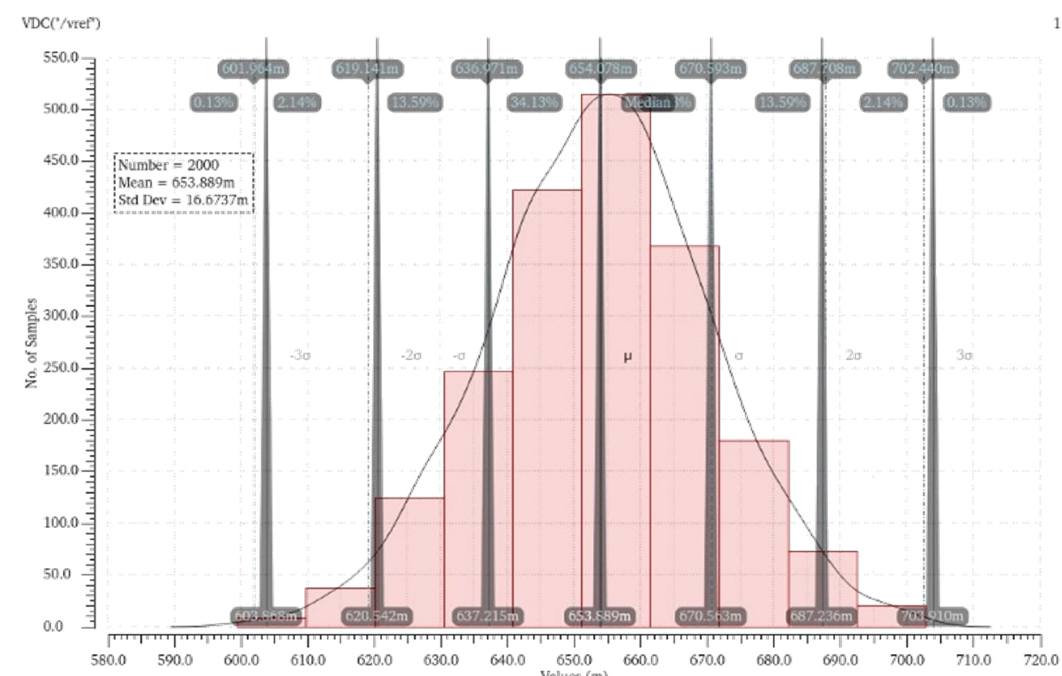
Figure 12. Distribution of output reference voltage with Monte Carlo simulations of 2000 runs.